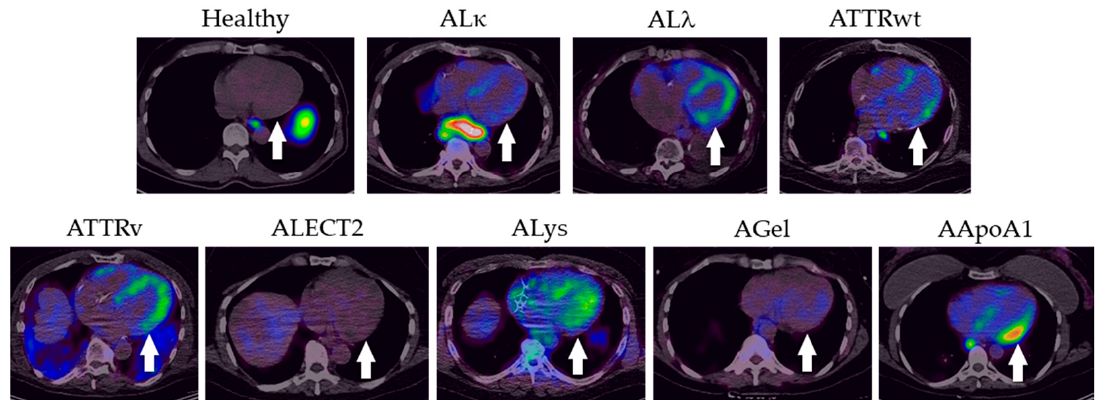
Figure 4. Transaxial images of the heart from a representative healthy subject and patients with diverse forms of systemic amyloidosis following injection of 124 I-p5+14. Retention of radiotracer in the left ventricular wall (arrow) was seen in all subjects except the healthy individual and patients with ALECT2 and AGel amyloidosis. Images have been scaled as described in Figure 3.